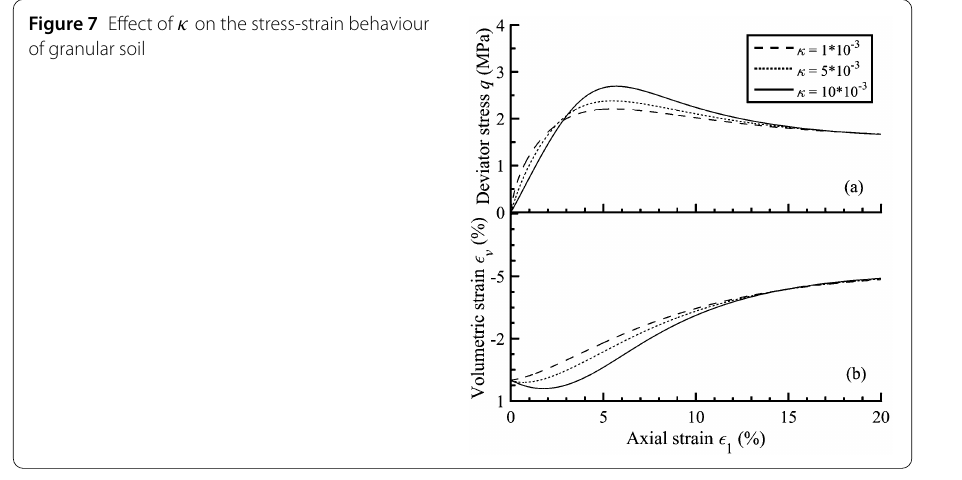
Figure 7 Effect of κ on the stress-strain behaviour of granular